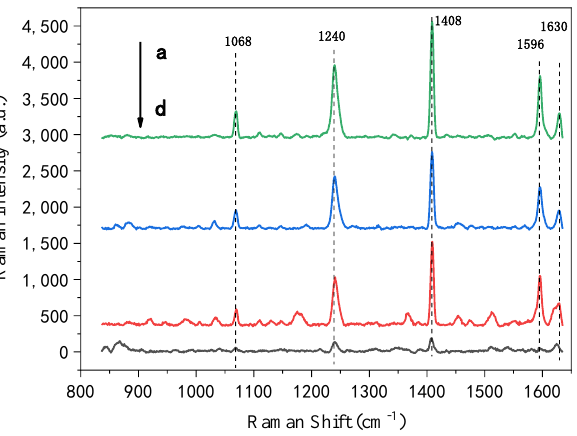
Figure 4. SERS spectra of pyrene–ethanol solution at different concentrations after dripping a volume of 10 µ L on the 10 mM–KBr–modified RGB-SERS substrate for SERS detection. Spectra (a) to (d) represent 100, 10, 1, and 0.1 µ M, respectively. Laser power: 13.8 MW; integration time: 1 s × 1; objective lens: 20×.